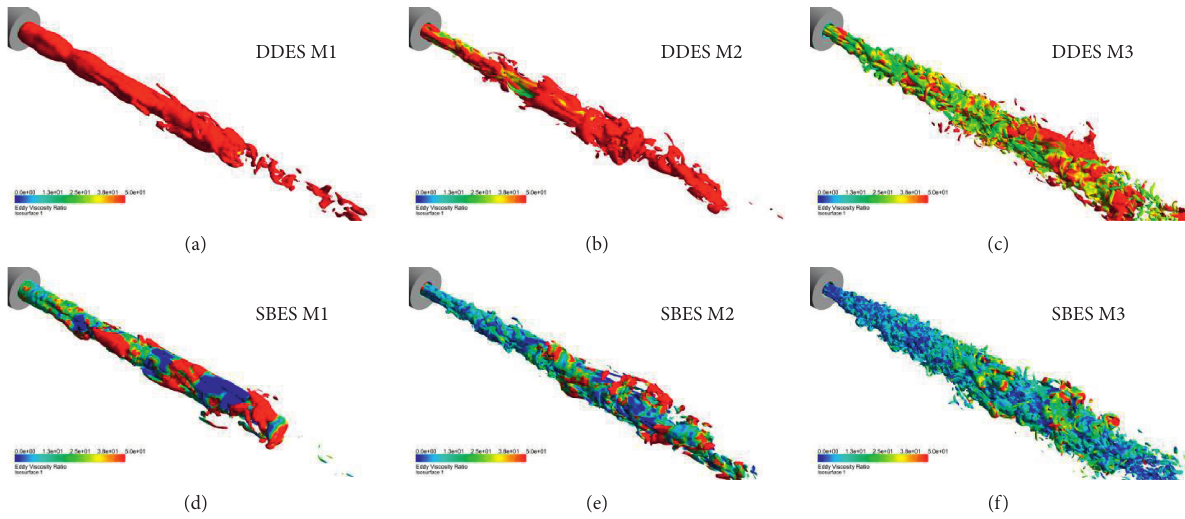
Figure 9: Isosurface of vorticity colored by eddy viscosity